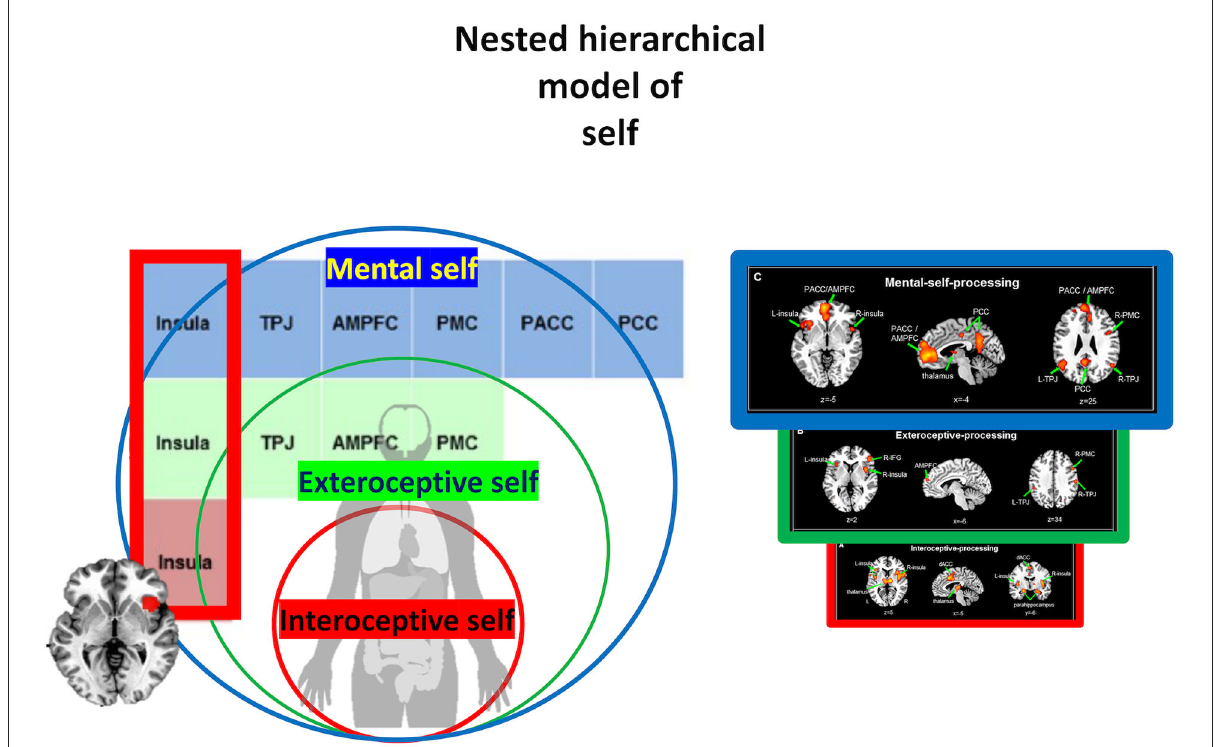
FIGURE3 Visual representation of the nested hierarchical model of self. L, left; R, right; dACC, dorsal anterior cingulate cortex; IFG, inferior frontal gyrus; TPJ, temporo-parietal junction; AMPFC, anterior medial prefrontal cortex; PMC, premotor cortex; PACC, pregenual anterior cingulate cortex; PCC, posterior cingulate